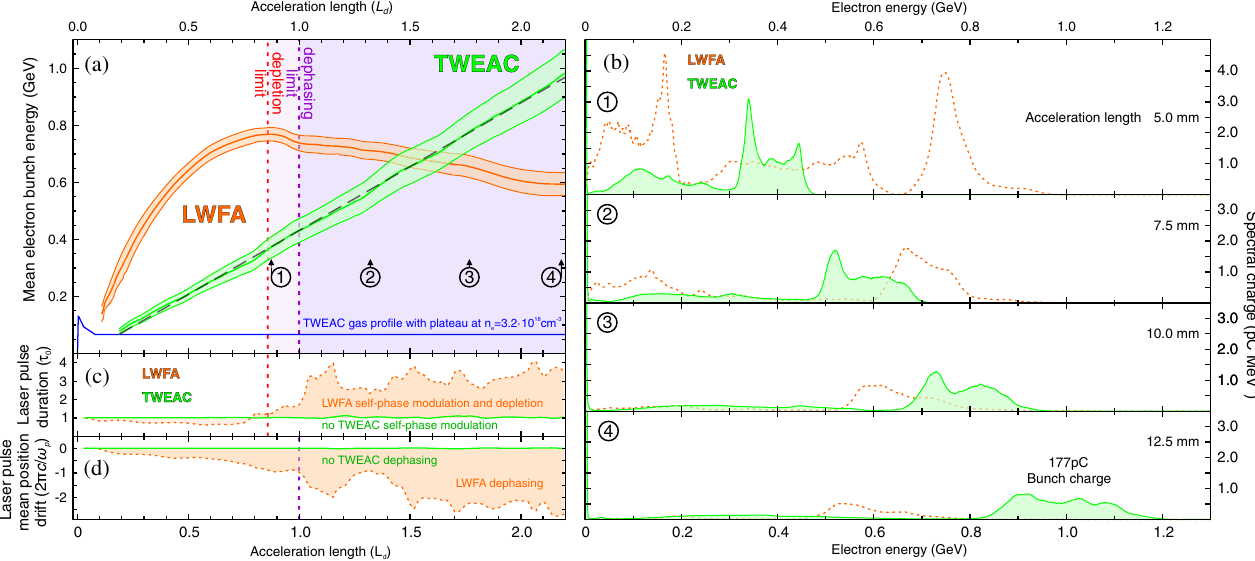
FIG. 4. Comparison of a LWFA and a 60°-TWEAC scenario at the same plasma density and peak laser intensity, contrasting the accelerators based on similar plasma dynamics. (a) The mean electron bunch energy of Traveling-Wave Electron Acceleration (green) and a corresponding self-injected laser-wakefield accelerator (orange) with respect to the accelerated distance normalized to the ¼ 5 . 70 mm. The bunch energy spread (standard deviation) is represented by the shaded areas, respectively. For dephasing length L d TWEAC, the acceleration remains constant and does not saturate within the dephasing or depletion length. The linear fit (gray, dashed line) highlights the excellent linearity of the TWEAC acceleration over the entire distance. (b) Electron spectra of all electrons in the TWEAC (green, solid line) and LWFA (orange, dashed line) scenario that are propagating within a 27-mrad (total angle) cone along the y axis at subsequent stages of acceleration. (c) The on-axis pulse duration of the TWEAC scenario compared to a standard LWFA, illustrating the absence of self-phase modulation achieved through the field-cycling mechanism in TWEAC. (d) The respective drift of the average on-axis longitudinal laser position compared to a test particle moving with the speed of light. Within numerical accuracy, the TWEAC laser field remains stationary and thus displays no